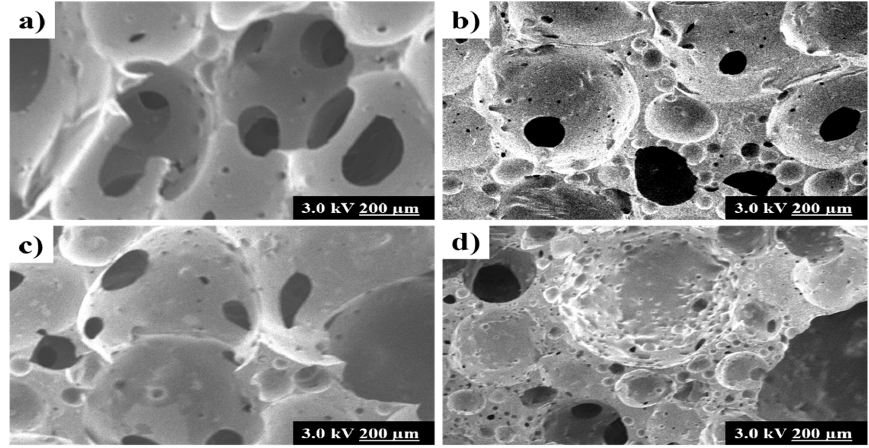
Figure 3. ( a ) COPUF, ( b ) AC/COPUF, ( c ) Z/COPUF, ( d ) B/COPUF.